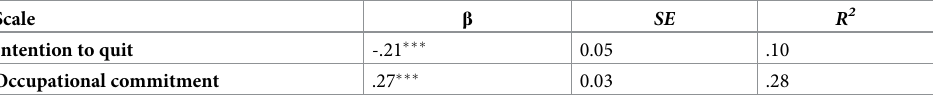
Table 5. Results of the regression analysis for the relationships between intention to quit and occupational com- mitment with enthusiasm for teaching. Scale